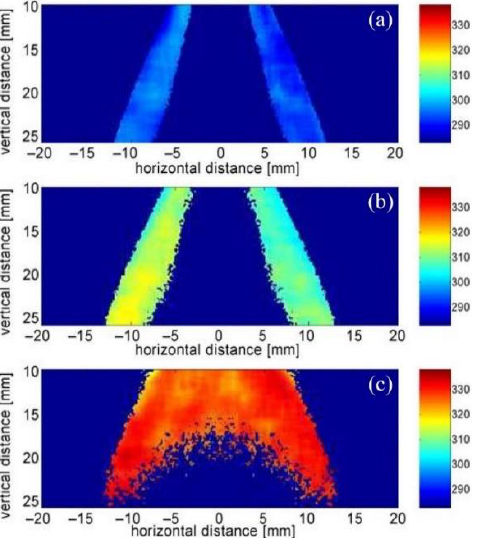
Figure 21. Temperature fields of spray with different initial liquid-phase temperatures: ( a ) T = 296 K, ( b ) T = 343 K, ( c ) T = 393 K [92]. Reprinted with permission from [92]. Springer Nature, 2006.